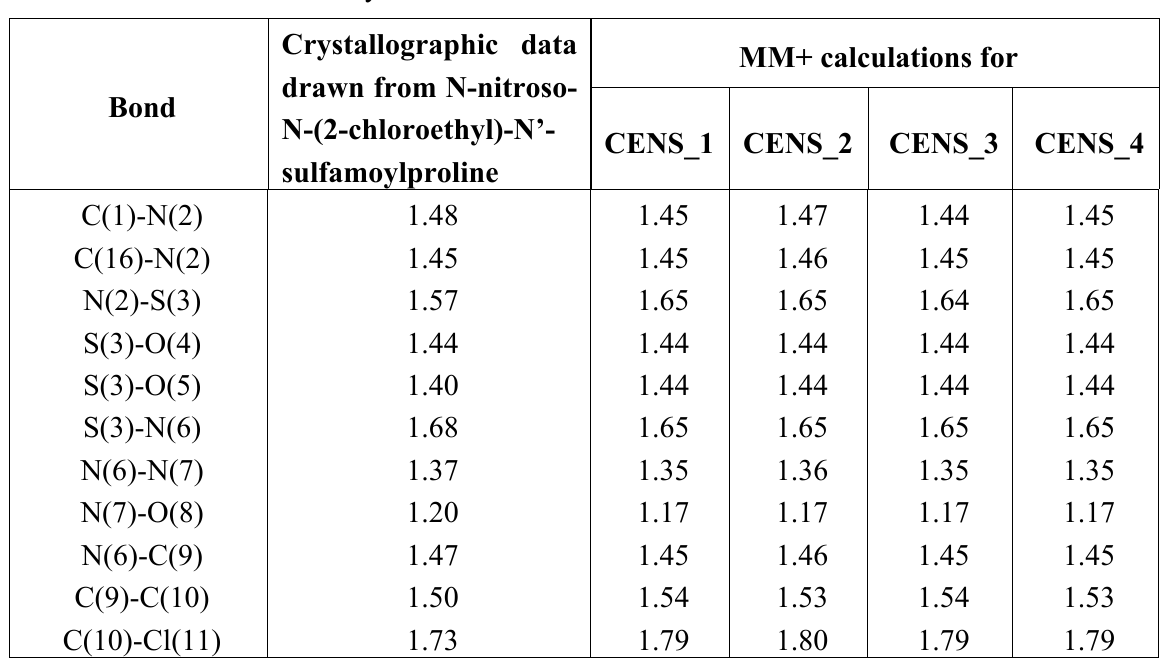
Table 3: Comparison of bond length (Å) parameters obtained by X-ray crystallography for the common fragment of the N-nitroso-N-(2-chloroethyl)-N’-sulfamoylproline and that with those obtained by molecular mechanics